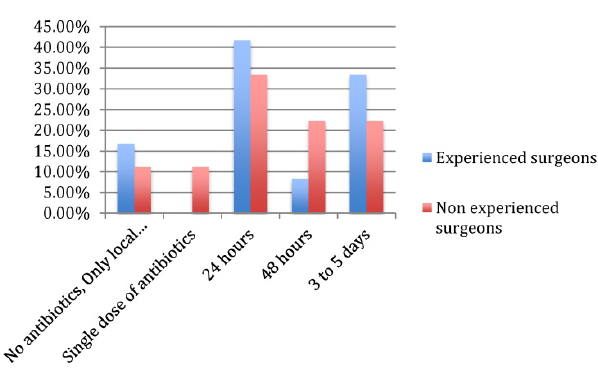
Figure 5. Comparison between experienced vs inexperienced surgeons for AB